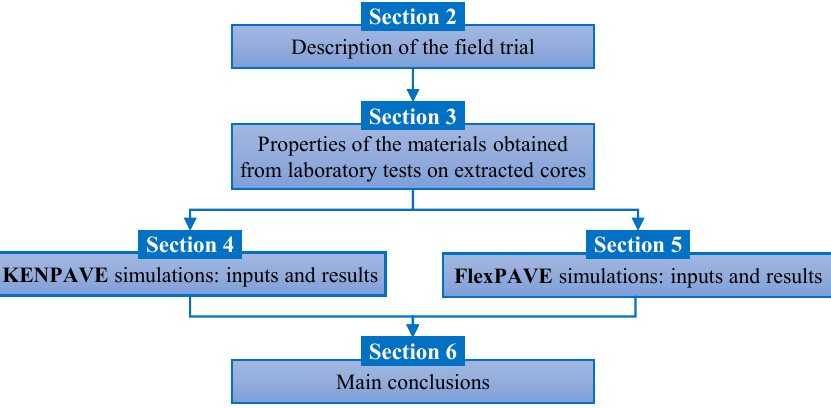
Figure 1. Structure and main contents of the paper.